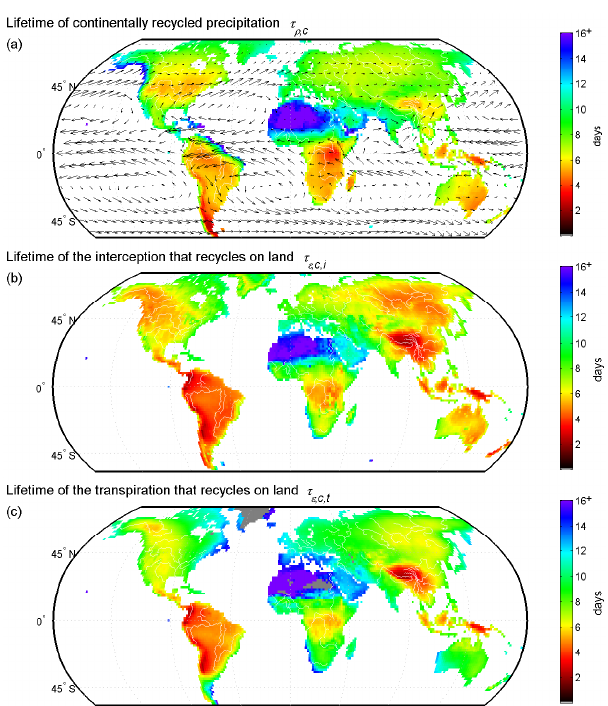
Figure 5. Local length scales of the moisture recycling process (1999–2008). (a) Length scale of precipitation recycling λ ρ , (b) length scale of evaporation recycling for interception λ ε, i , and (c) length scale of evaporation recycling for transpiration λ ε, t . Grey values on land indicate no data, due to the fact that the evaporative flux in question is 0. Note that lower values indicate higher moisture feedback strength. The arrows in (a) indicate the moisture fluxes in the lowest part of the atmosphere (approximately the lowest 2km of the atmosphere at standard pressure, Eq.